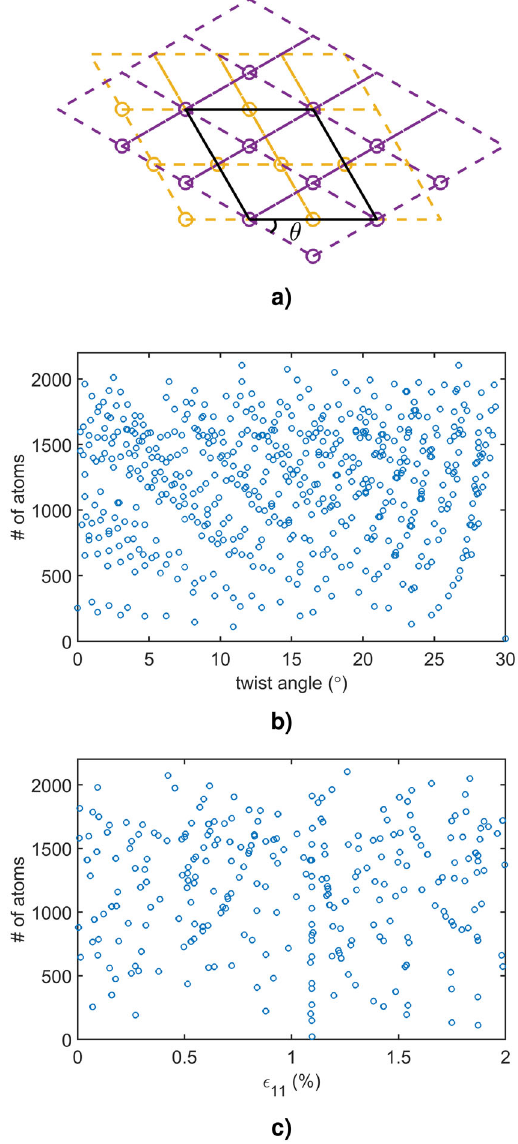
Fig. 3 Analysis of the possible MoS 2 /SnS 2 bi-layers supercells. a a sketch of a supercell with a twisting angle θ = 30 ∘ . The lattices of MoS 2 and SnS 2 are represented by orange and purple grids, respectively. The distribution of supercells for MoS 2 /SnS 2 bi-layers, where the individual layers are strained by <2%: b number of atoms against the twisting angle; c number of atoms against the in-plane lattice strain, ε 11 .